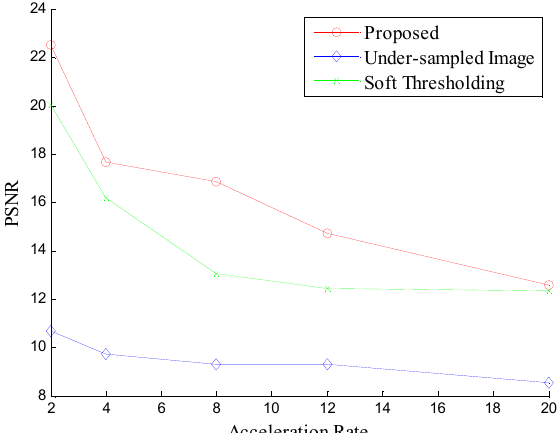
Figure 15. The performance using the peak signal-to-noise ratio (PSNR). PSNR of our method is better at all acceleration rates as compared to the soft thresholding method.